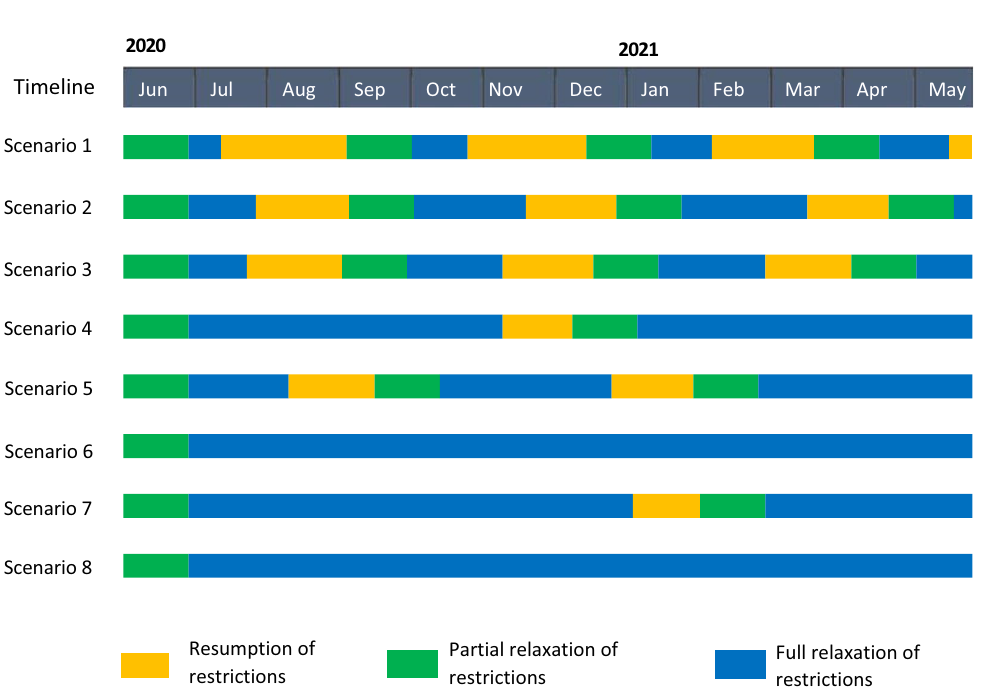
Figure 1. Estimated time spent under resumption and relaxation of restrictions between June 1, 2020 and May 31, 2021 by adherence to social distancing and mask-wearing. Yellow bars indicate the time spent under resumption of restrictions. Green and blue bars indicate the time up to 4 weeks (partial relaxation) and ≥ 4 weeks (full relaxation) after relaxation of restrictions, respectively. Adherence to mask-wearing is assumed as follows: 0% (Scenario 1 and 2), 50% (Scenario 3 and 4), 70% (Scenario 5 and 6), or 90% (Scenario 7 and 8). Adherence to social distancing is assumed to be 0% (Scenario 1, 3, 5, and 7) or 50% (Scenario 2, 4, 6, and